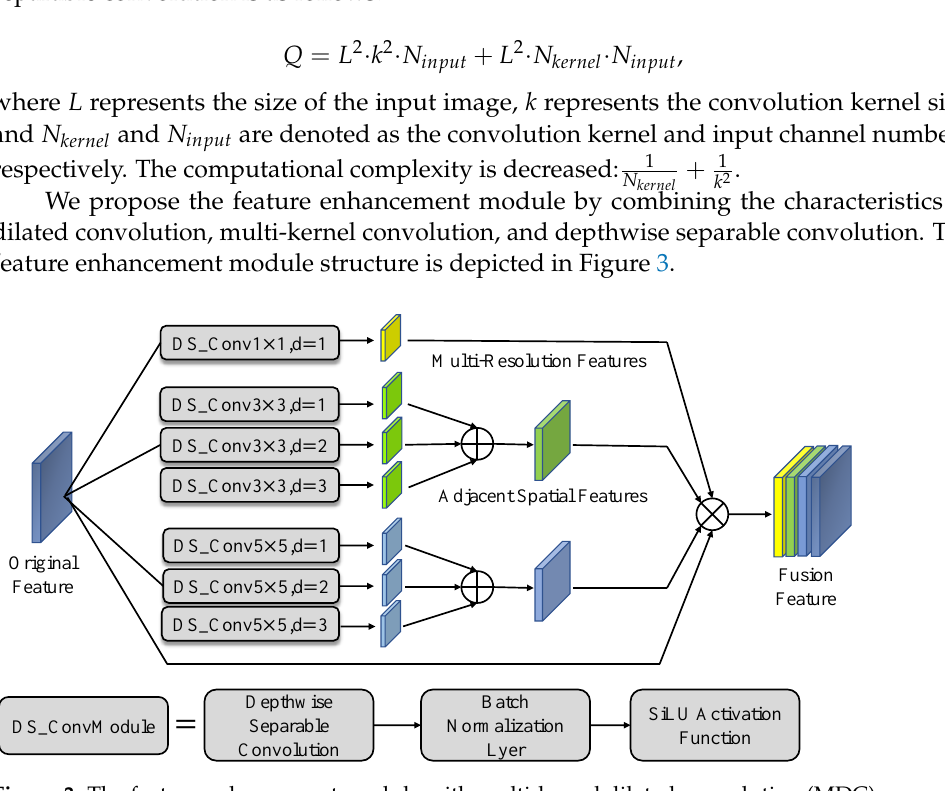
Figure 3. The feature enhancement module with multi-kernel dilated convolution